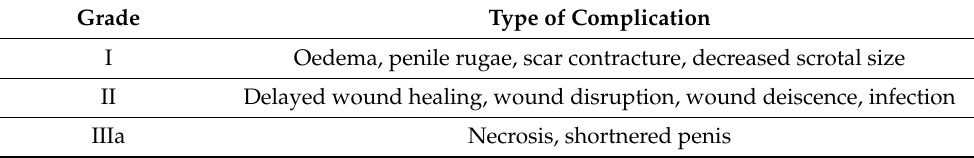
Table 3. Classification of surgical complication according to Clavien